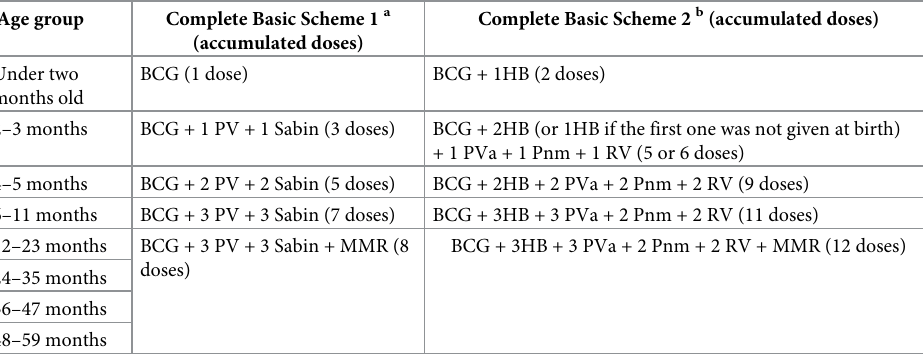
Table 1. Accumulated doses in the two complete basic schemes valid between 2000 and 2018 by age